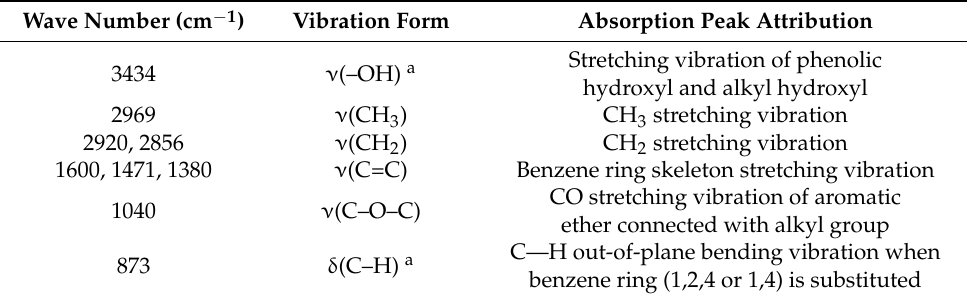
Figure 5. FTIR images of BPF and PF resin films under five aging conditions for 960 h. Table 2. Peaks and assignment of FTIR spectra for BPF and PF resins.